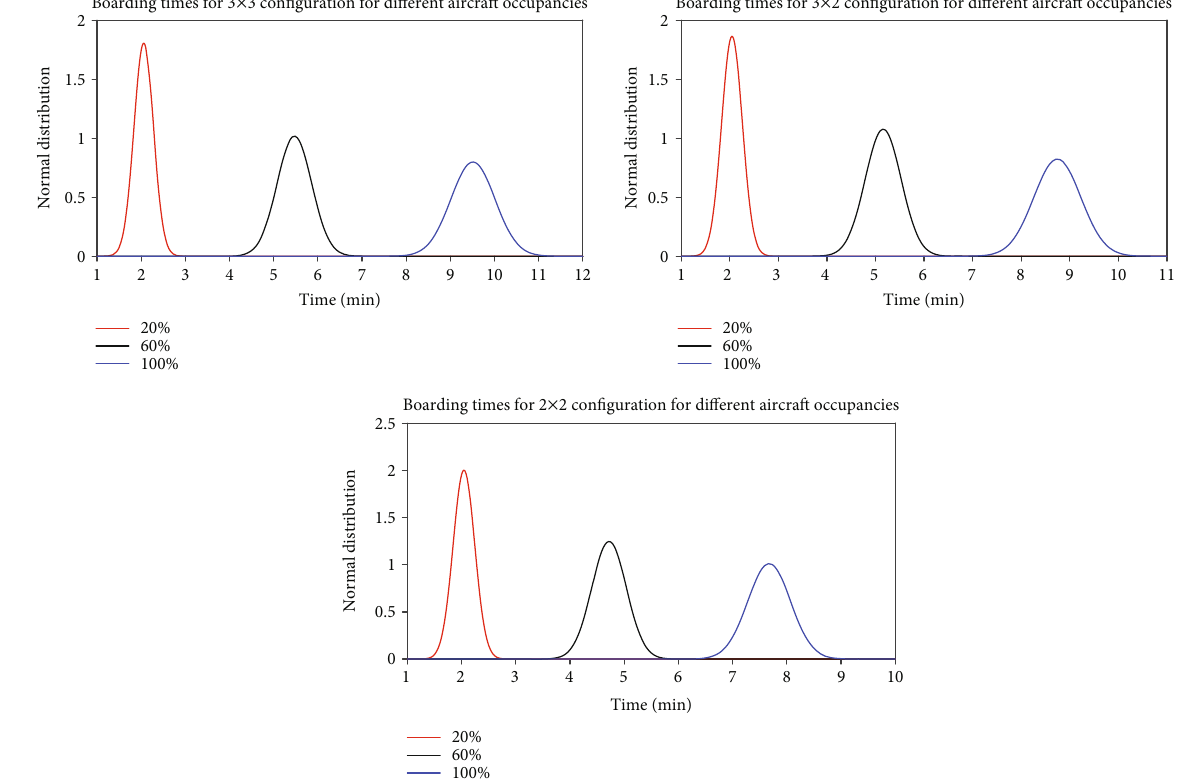
Figure 5: Fitted normal distribution curves for the three aircraft con fi gurations using the random boarding strategy for di ff erent % of aircraft